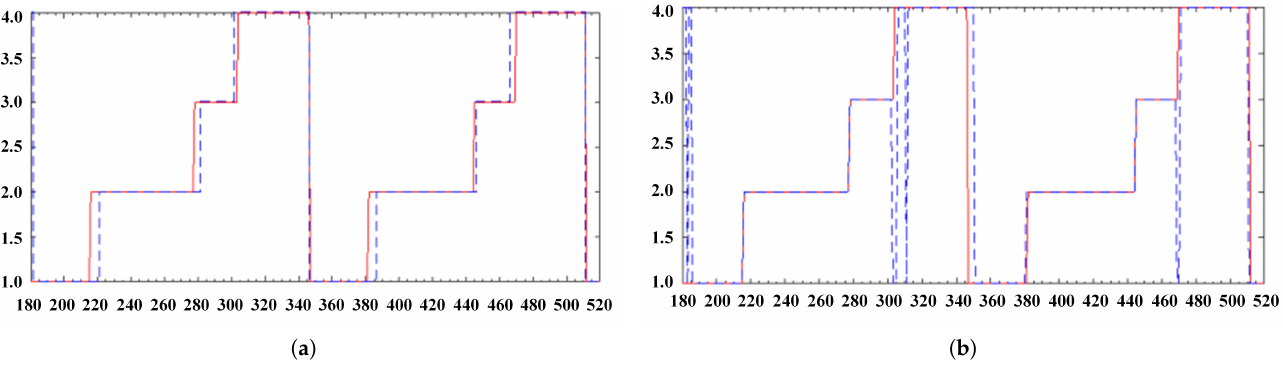
Figure 17. State sequence ( a ) Recognized by HMM ( b ) Recognition sequence of